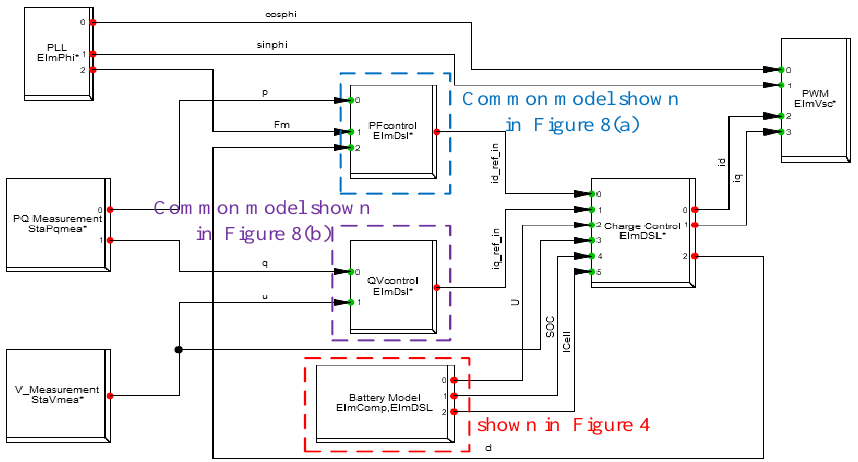
Figure 7. Composite model diagram of BESS.